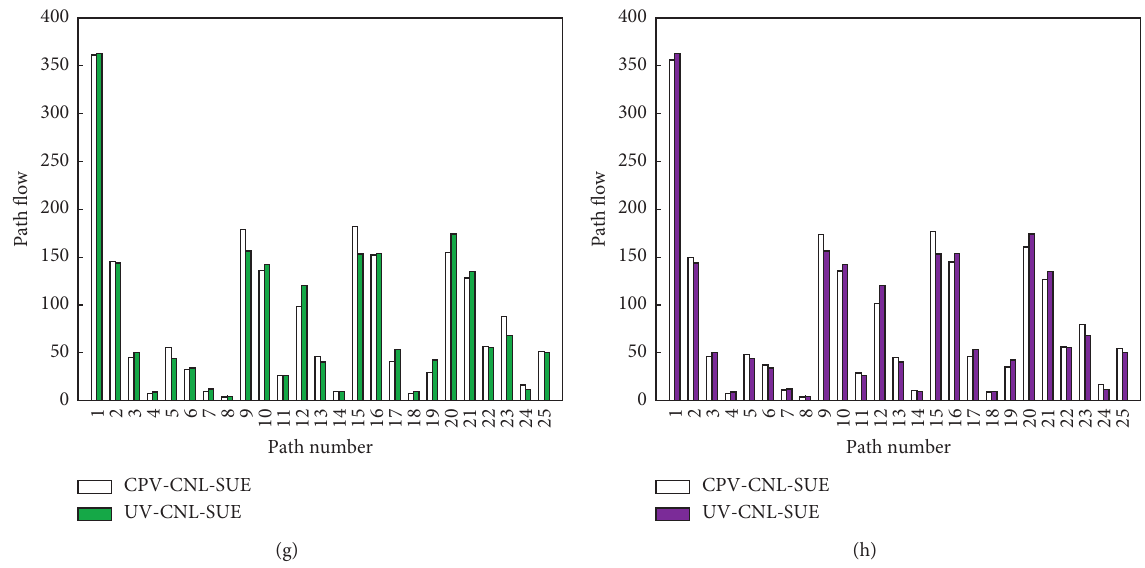
Figure 2: The path flow under different parameters. (a) θ � 0 . 25. (b) θ � 0 . 5. (c) θ � 0 . 75. (d) θ � 1. (e) μ � 0 . 25. (f) μ � 0 . 5. (g) μ � 0 . 75. (h) μ �